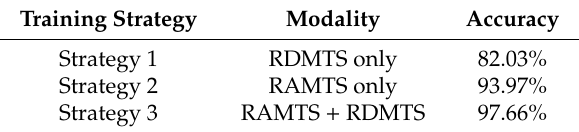
Table 3. Recognition Accuracy Comparison of Different Training Strategies.